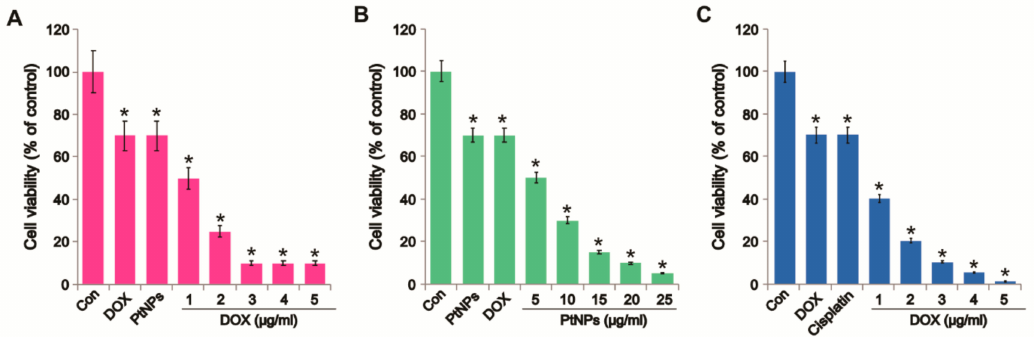
Figure 4. Dose-dependent e ff ect of DOX, PtNPs, and CIS on U2OS cell viability. ( A ) U2OS cells were incubated with di ff erent DOX concentrations (1–5 µ g / mL) and a fixed PtNPs concentration (10 µ g / mL) for 24 h and cell viability was measured using CCK-8. ( B ) U2OS cells were incubated with di ff erent PtNPs concentrations (5–25 µ g / mL) and a fixed DOX concentration (1 µ g / mL) for 24 h and cell viability was measured using CCK-8. ( C ) U2OS cells were incubated with di ff erent concentrations of DOX (1–5 µ g / mL) and a fixed CIS concentration (5 µ g / mL) for 24 h and cell viability was measured using CCK-8. Results are expressed as the mean ± standard deviation of three independent experiments. Di ff erences between the treated and control groups were measured using Student’s t -test and statistically significant di ff erences are indicated by * ( p < 0.05). The results are presented as mean ± standard deviation of three experiments. * p < 0.05 was considered significant; ** p < 0.01 was considered highly significant and *** p < 0.001 was considered very highly